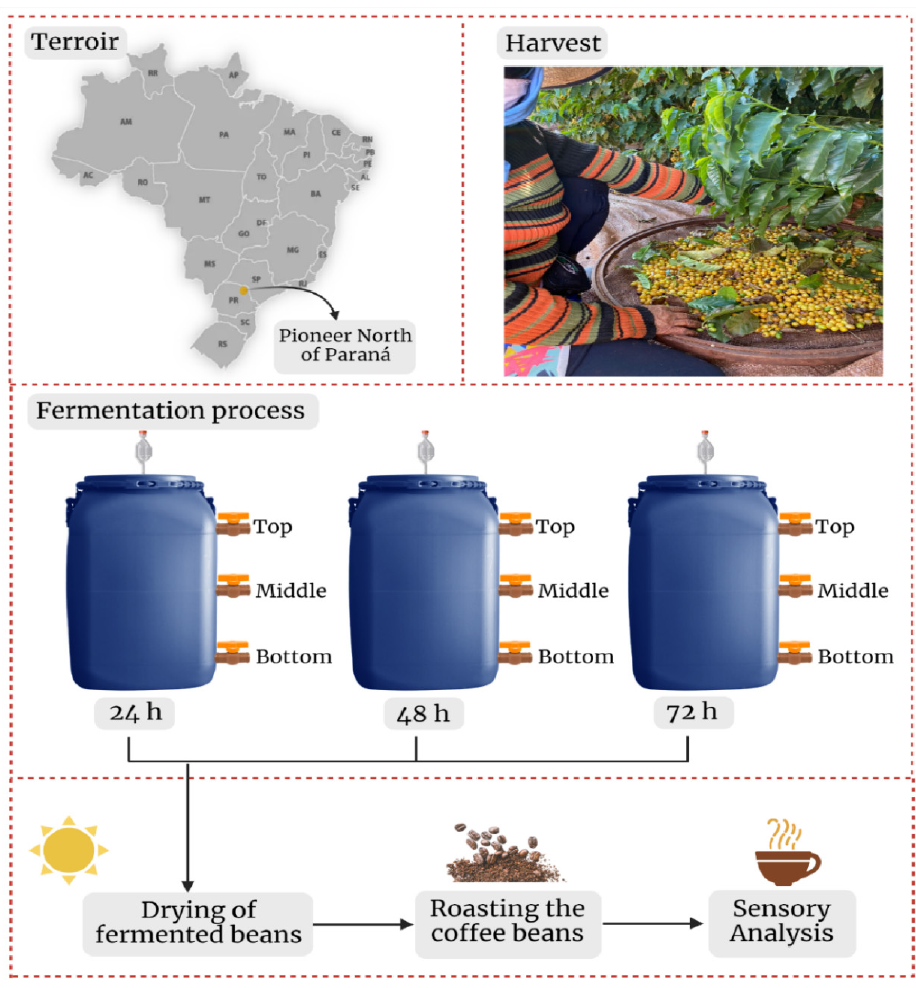
Figure 1. Flowchart showing the steps performed from harvest to sensory analysis.